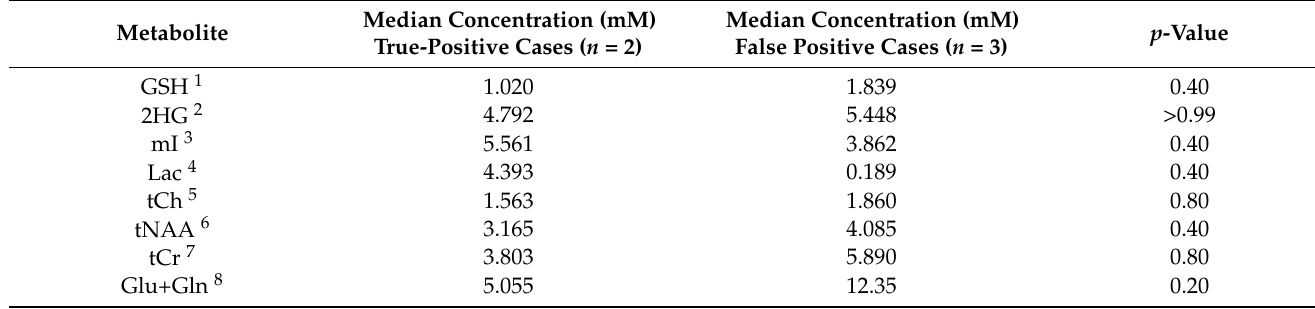
Table 2. Comparison of metabolites between true-positive and false-positive